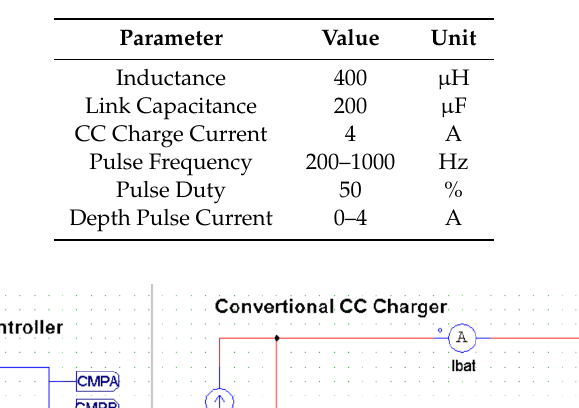
Table 2. Specifications and circuit parameters of the pulse charger.